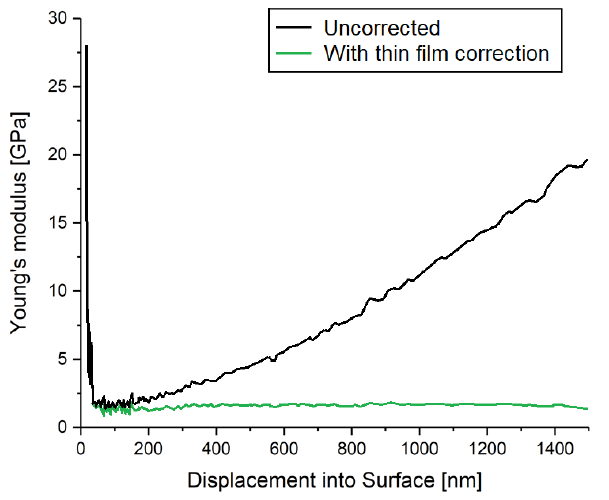
Figure A3. Impact of the thin film correction, i.e., considering and subtracting the silicon substrate.